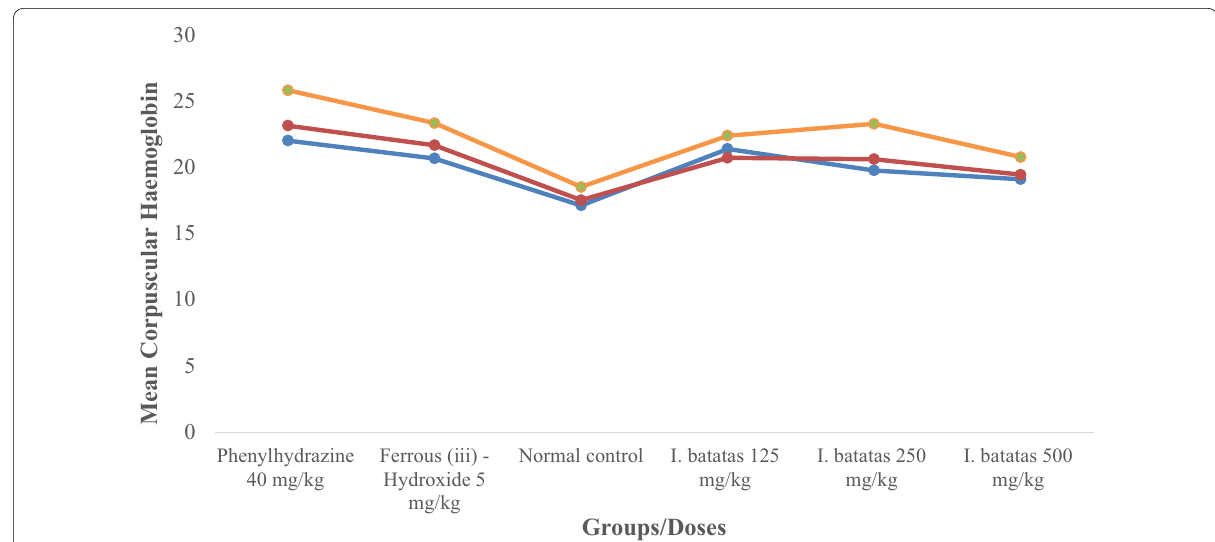
Fig. 7 Effect of Ipomoea batatas L . n-Hexane leaves extract on mean corpuscular haemoglobin in phenylhydrazine-induced anaemic rats. Blue— day 1, red—day 7, orange—day